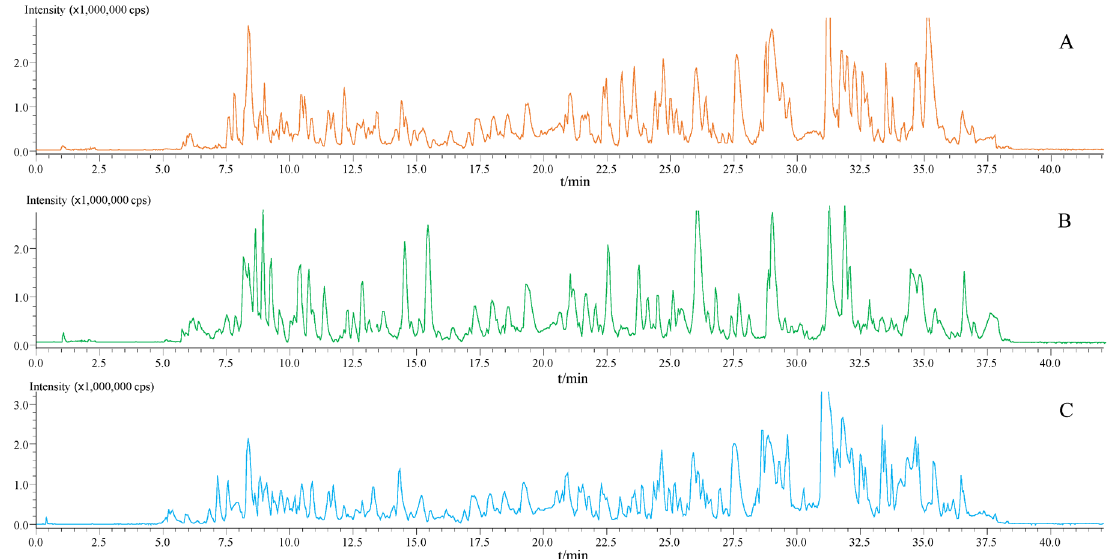
F1 x × Figure 1. Base peak chromatograms of E. sagittatum ESa, ( A ), E. koreanum EKo, ( B ) and E. pubescens EPu, ( C ), in negative ion